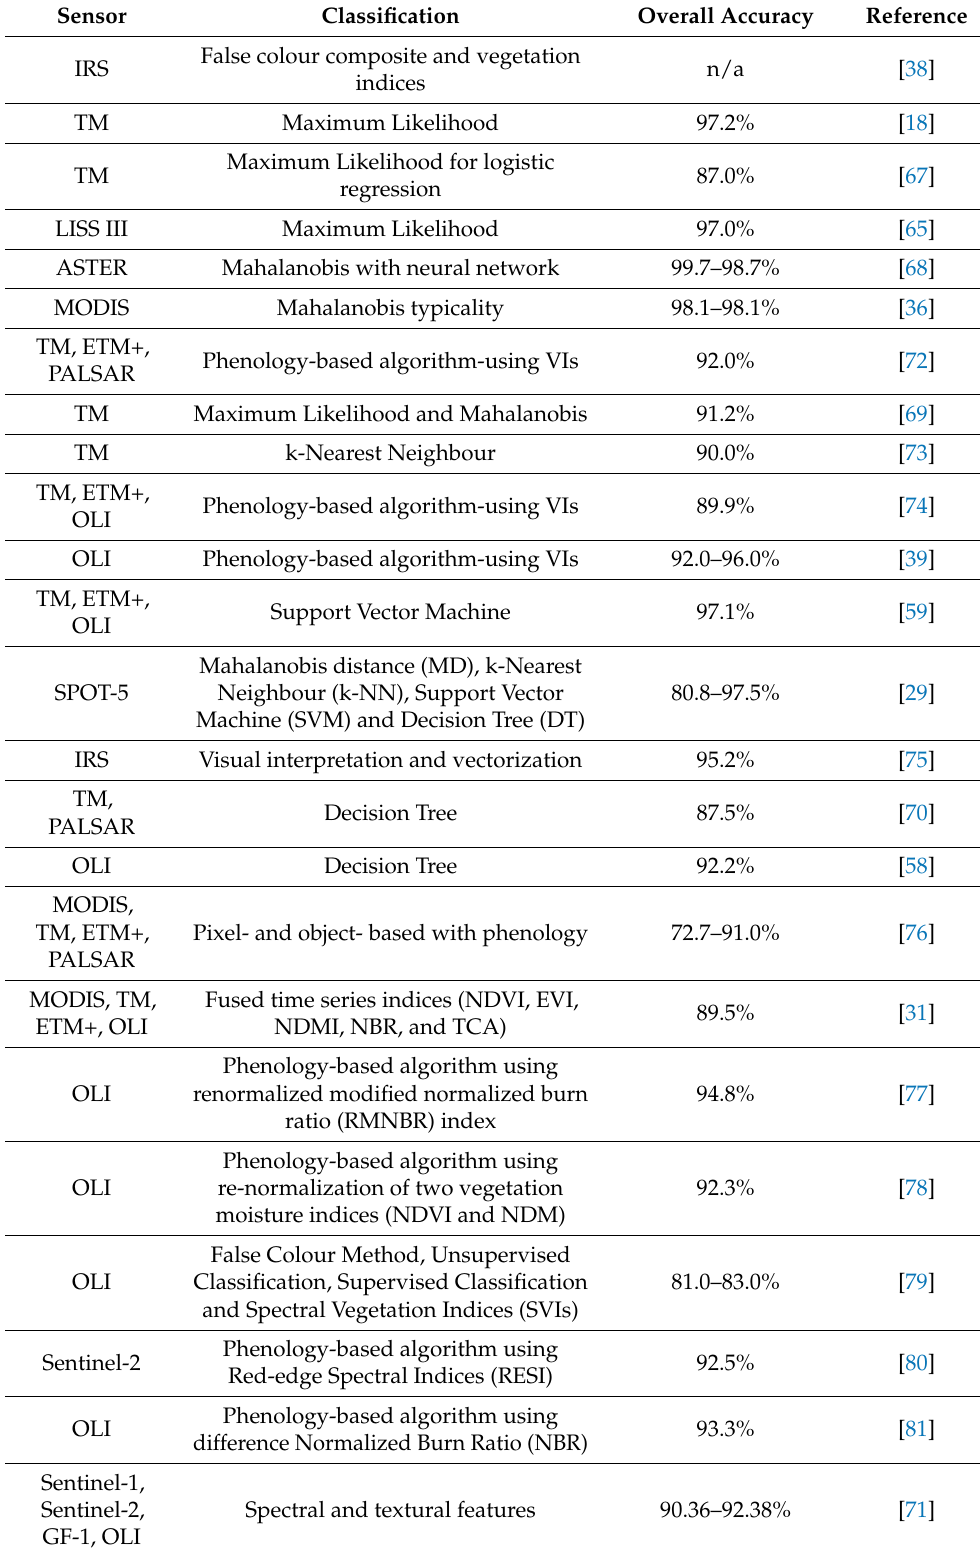
Table 4. Comparison of classification and overall accuracy for mapping rubber